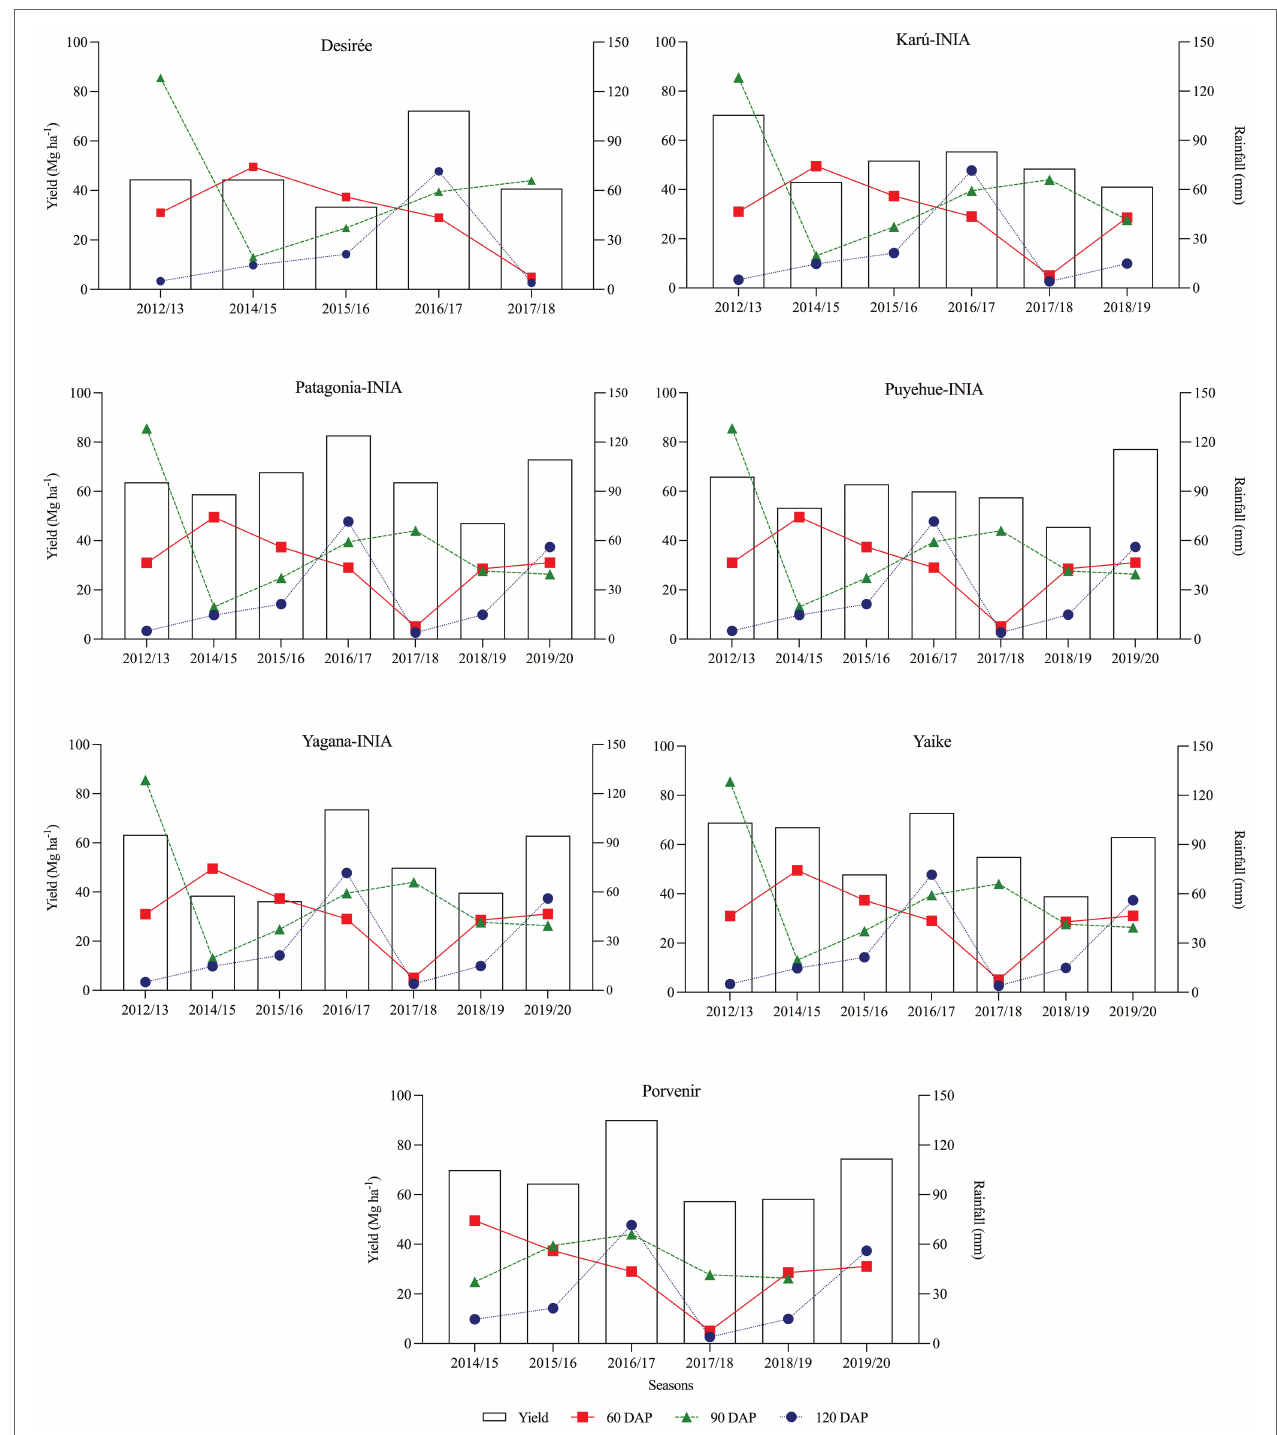
FIGURE 5 | Temporal relationship between potato tuber yield under rainfed conditions and rainfall at 60, 90, and 120 days after planting (DAP), from the 2012–13 to 2019–20 season. 60 DAP: 0–60 days, 90 DAP:60–90 days, and 120 DAP: 90–120